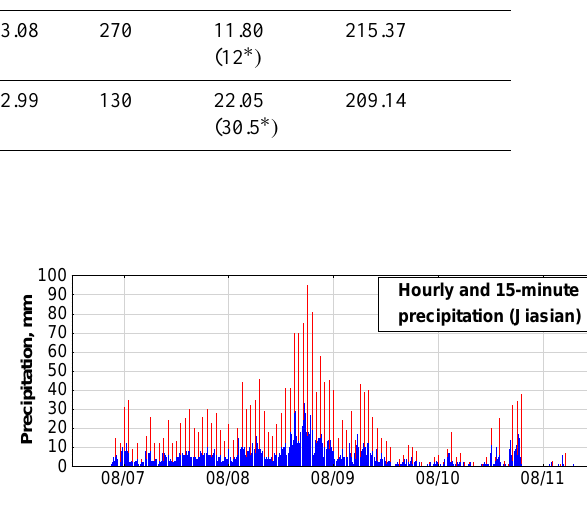
Figure 5 The hourly and quarter-hourly precipitation levels at the Jiasian rainfall Fig. 5. The hourly and quarter-hourly precipitation levels at the gauge station (C0V250) during Typhoon Morakot (August 7 – 11, 2009). Jiasian rainfall gauge station (C0V250) during Typhoon Morakot (7–11 August